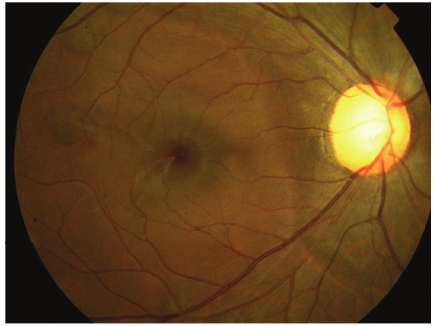
Figure 1: Color fundus photo (right eye).